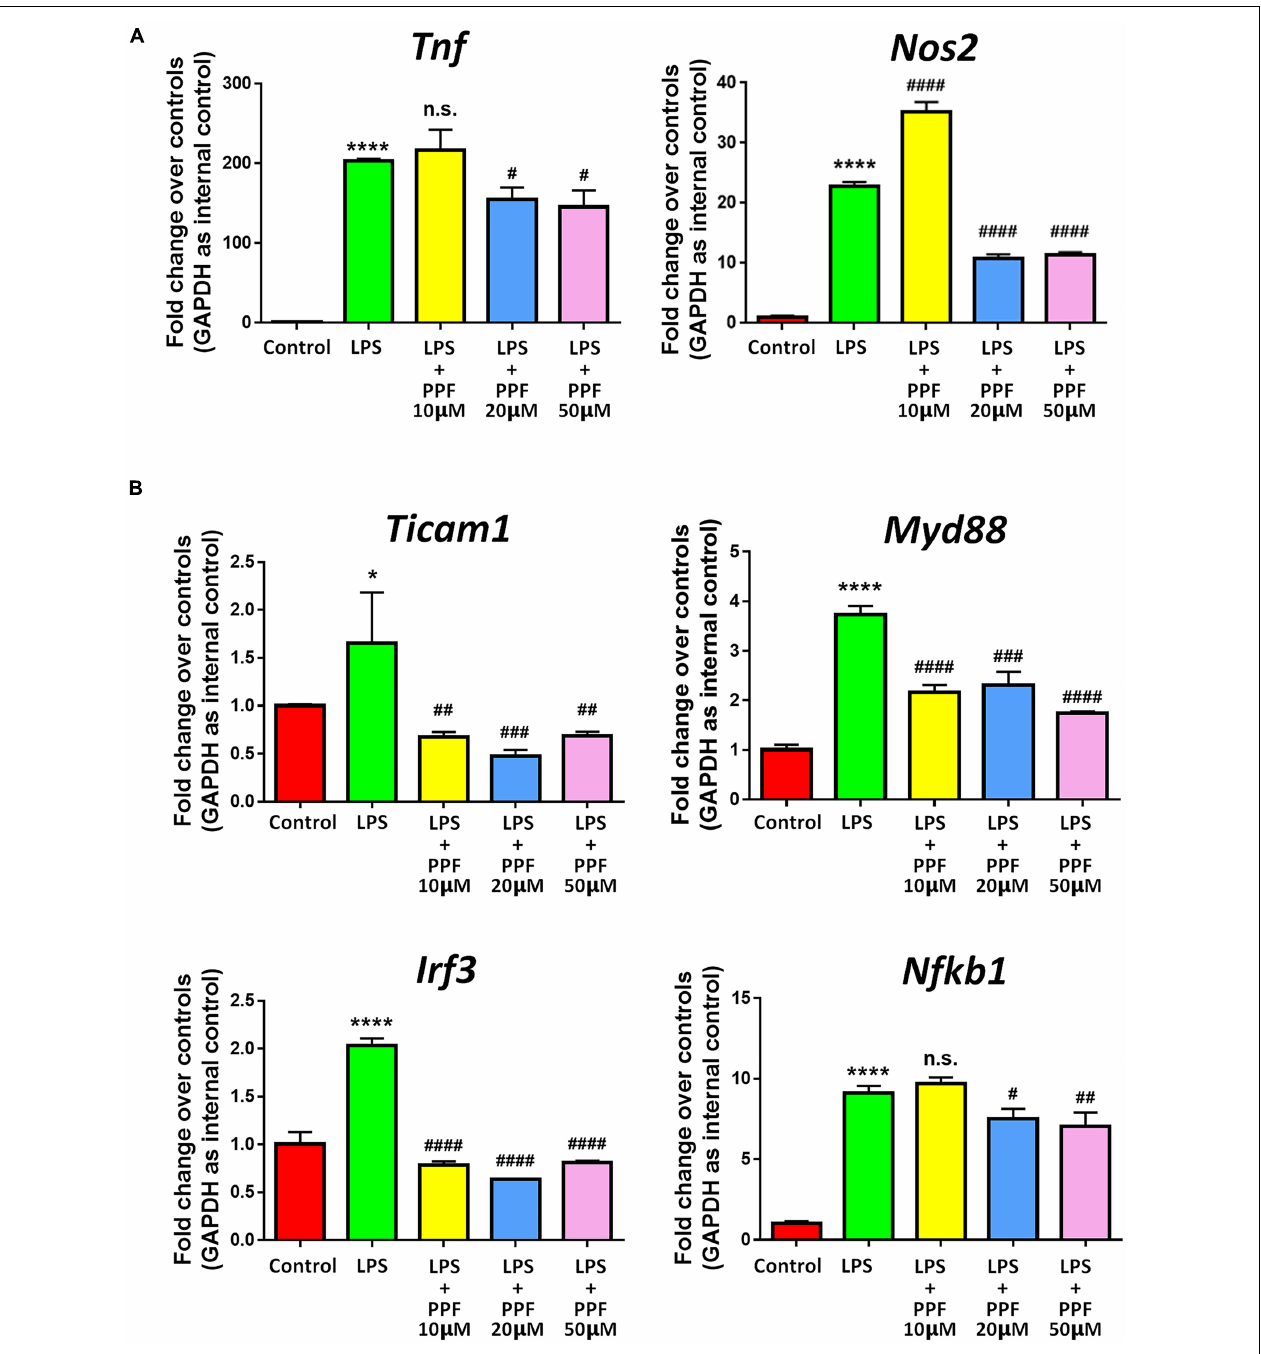
FIGURE 1 | Propofol inhibits LPS-stimulated microglia. Primary mouse microglia were stimulated by LPS, followed by propofol treatment for 2 days. (A) The transcript levels of pro-inflammatory genes Tnf and Nos2 in microglia were determined by qRT-PCR. (B) The transcript levels of NF- κ B signaling component genes Ticam1 , Myd88 , Irf3 , and Nfkb1 in microglia were determined by qRT-PCR. Data were represented as mean ± SD from three independent experiments. The symbols * and **** denote p < 0.05 and p < 0.0001, respectively, in comparison with control group. The symbols # , ## , ### , and #### denote p < 0.05, p < 0.01, p < 0.001, and p < 0.0001, respectively, in comparison with LPS group. n.s. denotes non-significant. PPF, propofol.